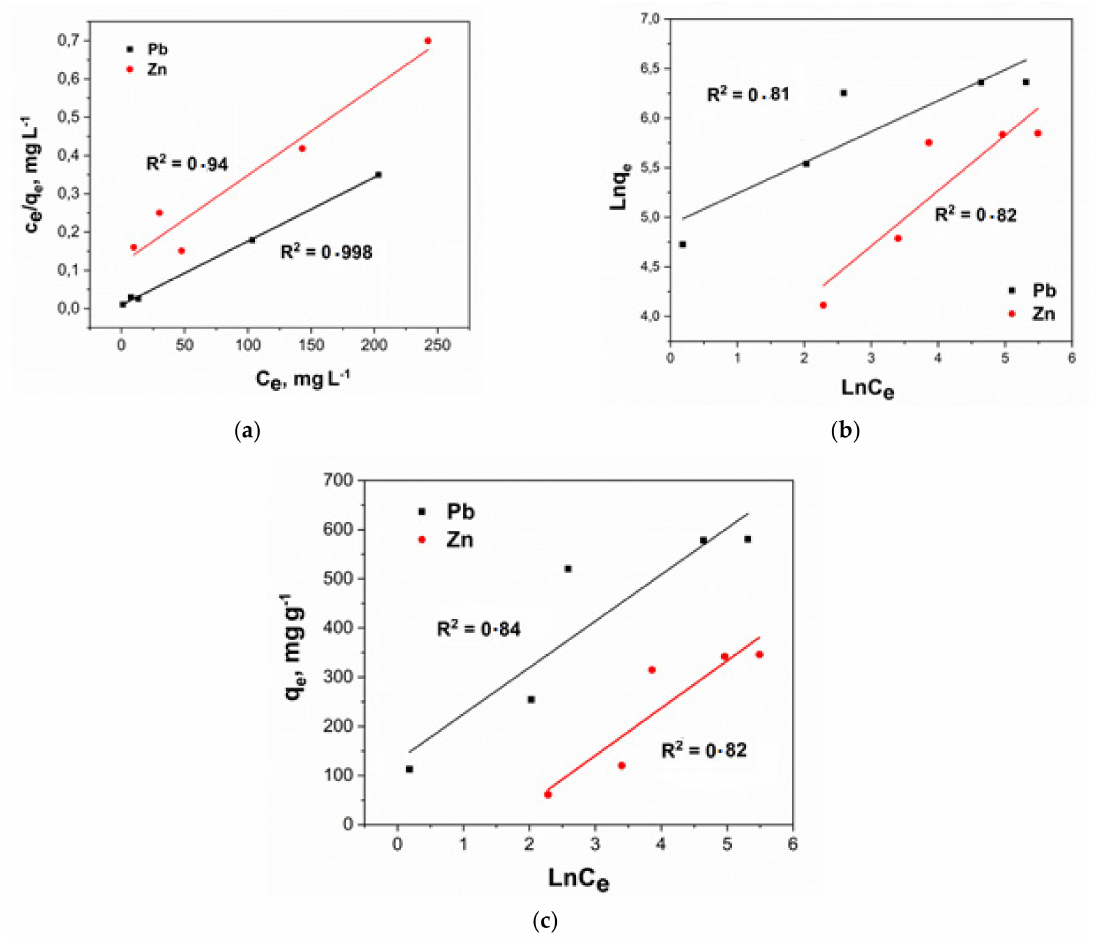
Figure 12. Linear forms of the Langmuir ( a ), Freindlich ( b ) and Temkin ( c ) equations. Table 5. Isotherms parameters for lead and zinc sorption on the nanocomposite. Langmuir Freundlich Temkin